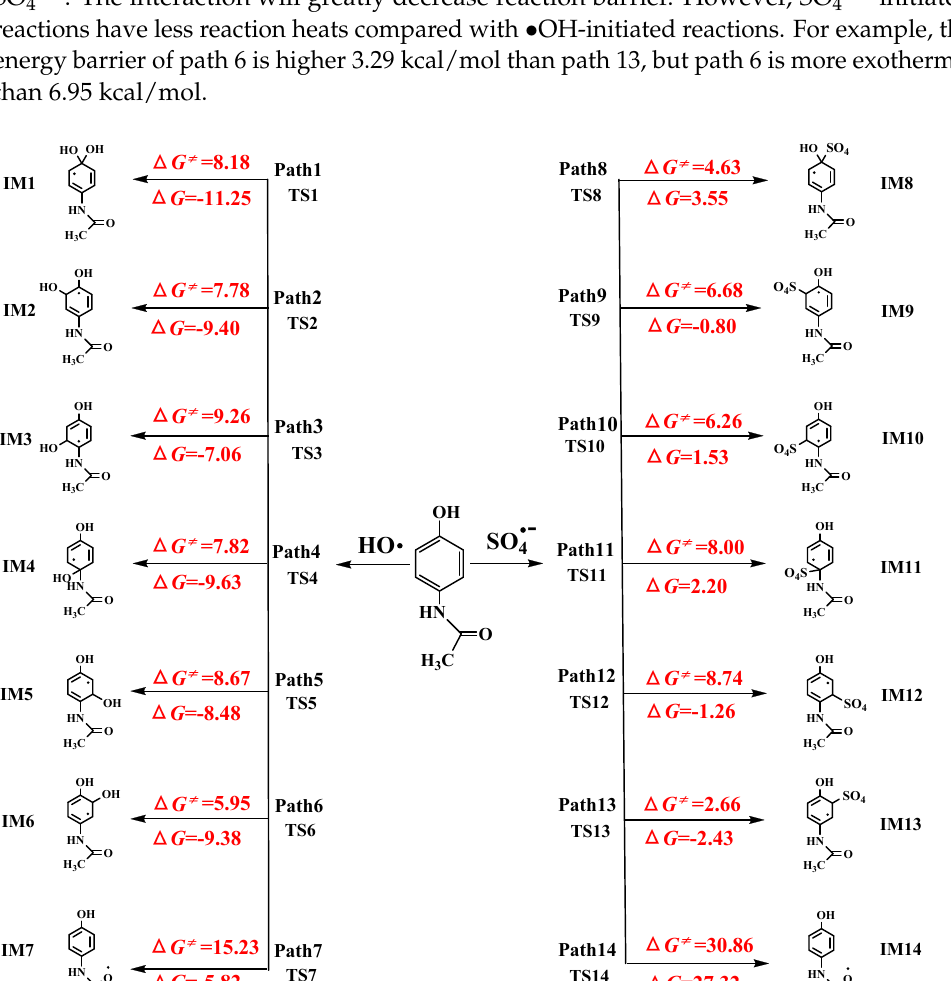
. Figure 3. The free energy diagram of RAF pathways initiated by two radicals.